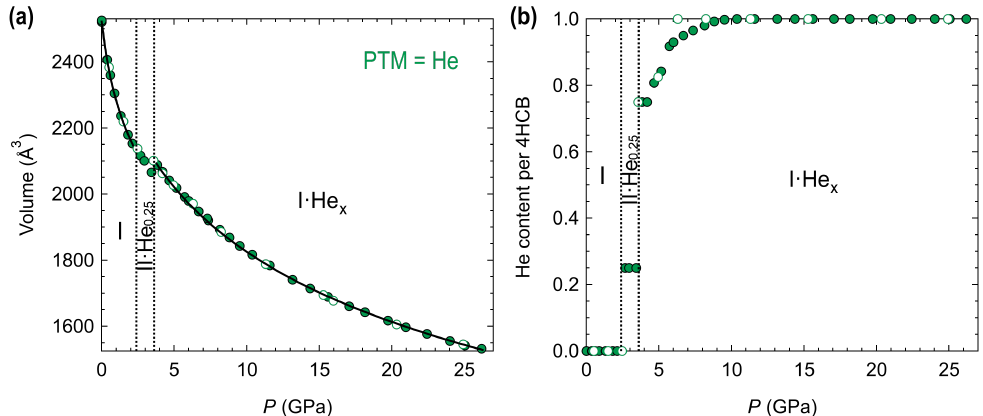
Figure 4. Pressure dependence of ( a ) the unit cell volume, with the solid black lines indicating third-order Vinet equation of state fits, and ( b ) the helium content in the unit cell per 4HCB molecule (we note that there are 16 4HCB molecules in the unit cell). Decompression points are indicated by the open markers and the transition points are indicated by dotted lines.